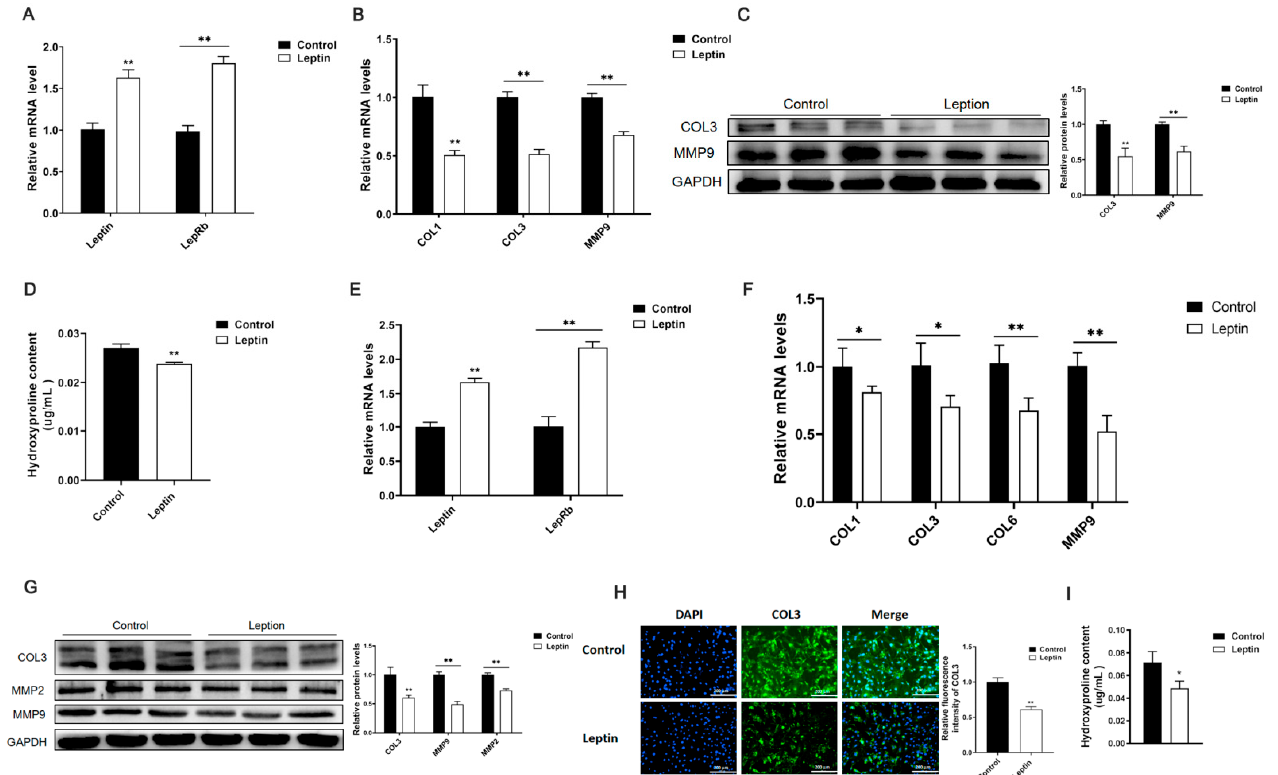
Figure 1. Leptin inhibits adipose tissue fibrosis in mice. When the mice were injected with leptin for 7 days, we extracted total RNA and protein from the inguinal adipose tissue of the mice. ( A ) The relative mRNA expression level of leptin and its receptor ( n = 4). ( B ) The relative mRNA expression levels of fibrosis-related genes COL1, COL3, and MMP9 ( n = 4). ( C ) The relative expression levels of fibrosis-related proteins COL3 and MMP9 ( n = 3). ( D ) The relative expression level of hydroxyproline in adipose tissue ( n = 4). Furthermore, we respectively treated the cells with 100 ng/mL leptin for 24 and 48 h, and extracted total RNA and protein. ( E ) The relative mRNA expression levels of leptin and its receptor ( n = 4). ( F ) The relative mRNA expression levels of fibrosis-related genes COL1, COL3, COL6, MMP9 ( n = 4). ( G ) The relative protein expression levels of fibrosis-related genes COL3, MMP2, MMP9 ( n = 4). ( H ) Immunofluorescence staining of COL3 in adipocytes, scale bar: 200 µ m ( n = 3). ( I ) The relative expression level of hydroxyproline in adipocytes ( n = 4). Values are means ± SD, * p < 0.05, ** p < 0.01 compared with the control group.